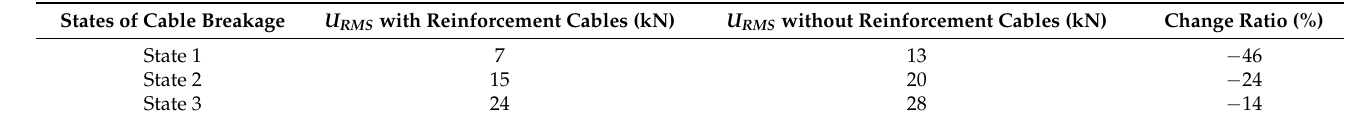
Table 5. Comparison of root-mean-square value results of the along-wind displacement responses of the bridge with or without reinforcement cables.